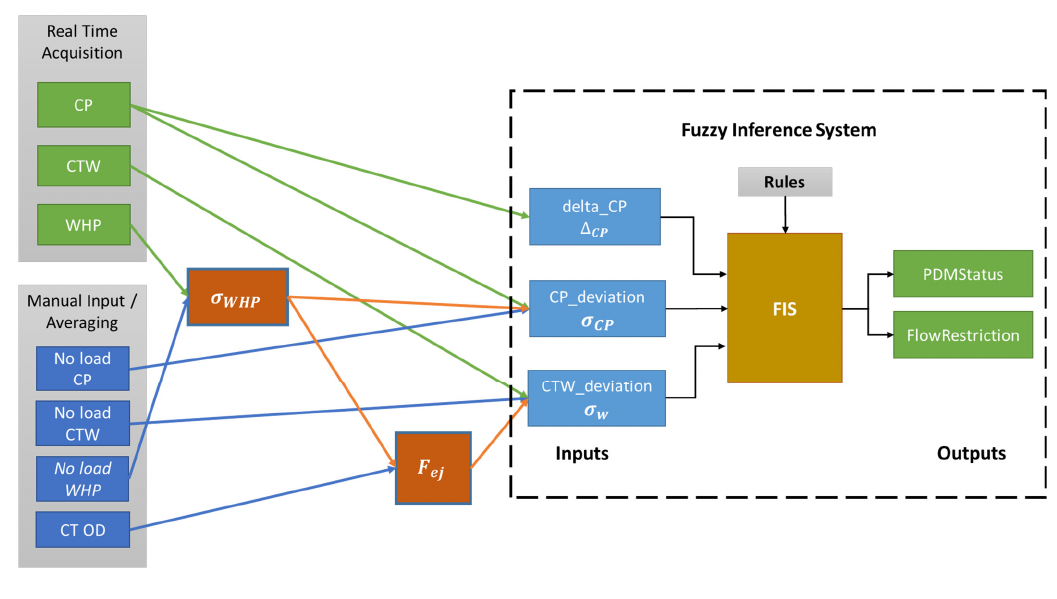
Figure 3. System data flow.